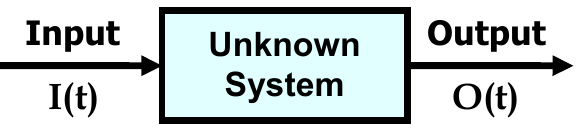
Fig. 1. Structure of an input-output